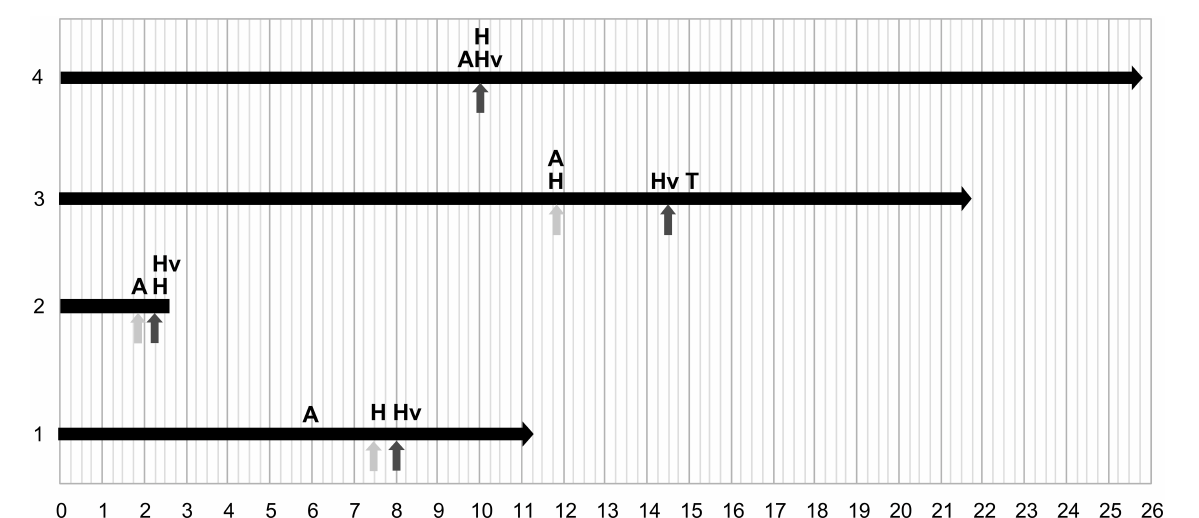
FIGURE1 Chronology of onset of clinical signs. 1–4 correspond to each patient of the cohort and axial axis to the age at onset of symptoms in years. The end of the black horizontal arrow corresponds to the last follow-up of the patient, or patient death. H represents hypothalamic involvement, A dysautonomia, Hv hypoventilation, T the occurrence of a tumor. The light-gray arrows indicate the time of the first hospital referral and the dark-gray arrows the time of diagnosis.